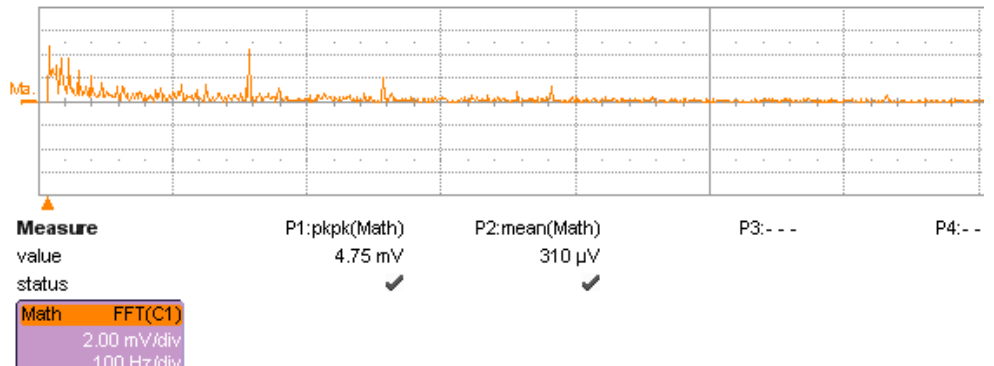
Figure 15. Noise spectrum density of vacuum microelectronic